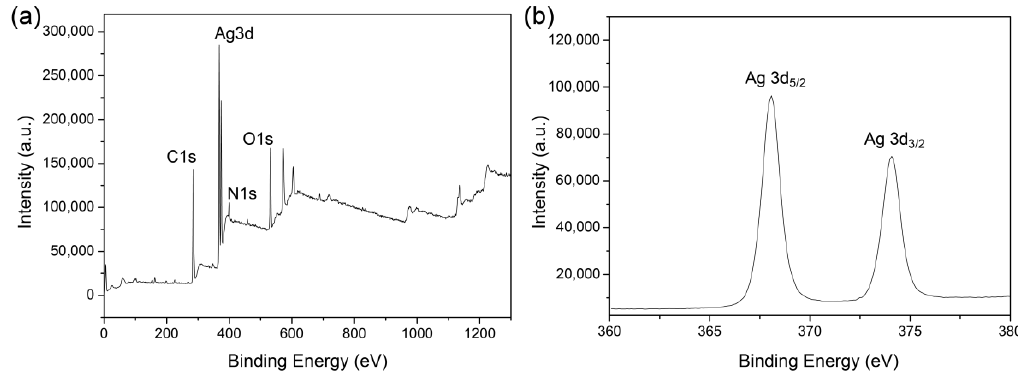
Figure 8. XPS spectra of the AgNPs/SS/agar film ( a ) and the deconvolution of the Ag (3d) peak ( b ).